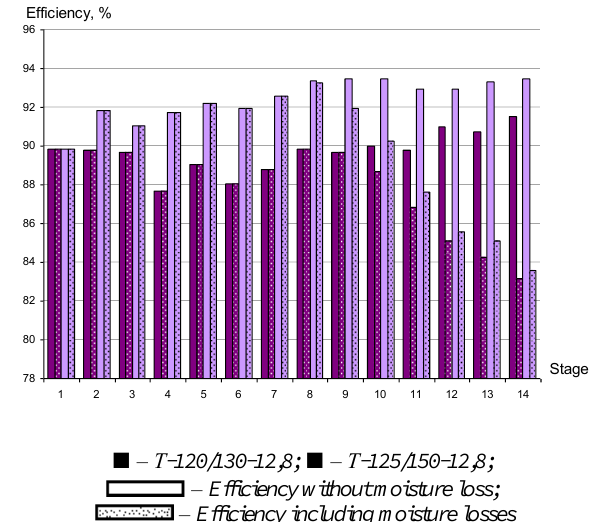
Figure 23: The flow eflciency of turbine blading systems in turbines CMP T-120/130-12,8 and T-125/150-12,8